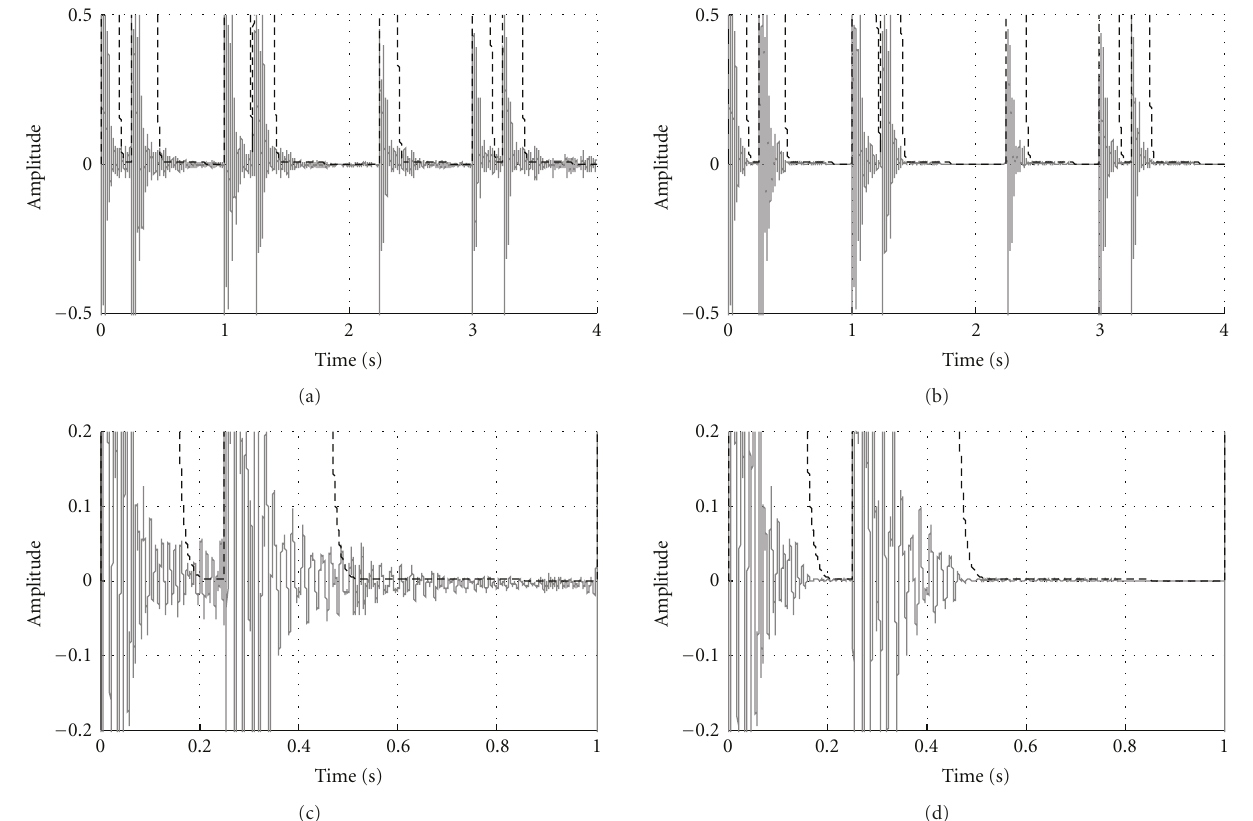
Figure 4: Kick drum recording before and after gating, (a) before gating, and (b) after gating, with δ bleed = − 60